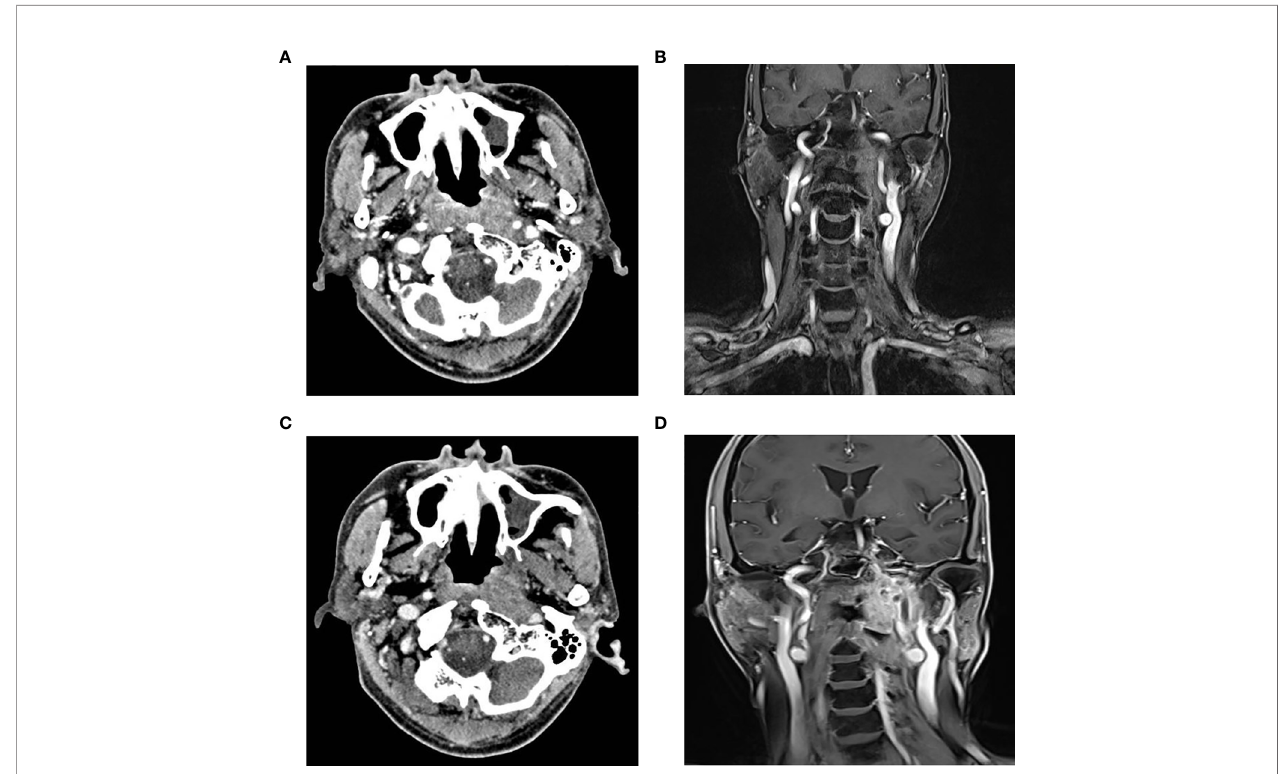
FIGURE 1 | Imaging examination of ICA before and after embolization (A) Horizontal enhanced CT showed that the tumor partially wrapped the left ICA; (B) Coronal enhanced MRI exhibited that the tumor invaded the left pharyngeal recess, parapharyngeal space, the longus capitis, sphenoid body and skull base, and partially surrounded the left ICA; (C, D) Horizontal enhanced CT and coronal enhanced MRI showed the undeveloped cavenous, lacerum, petrous and cervical segments of the left ICA. CT, Computer Tomography; MRI, Magnetic resonance imaging; ICA, Internal carotid